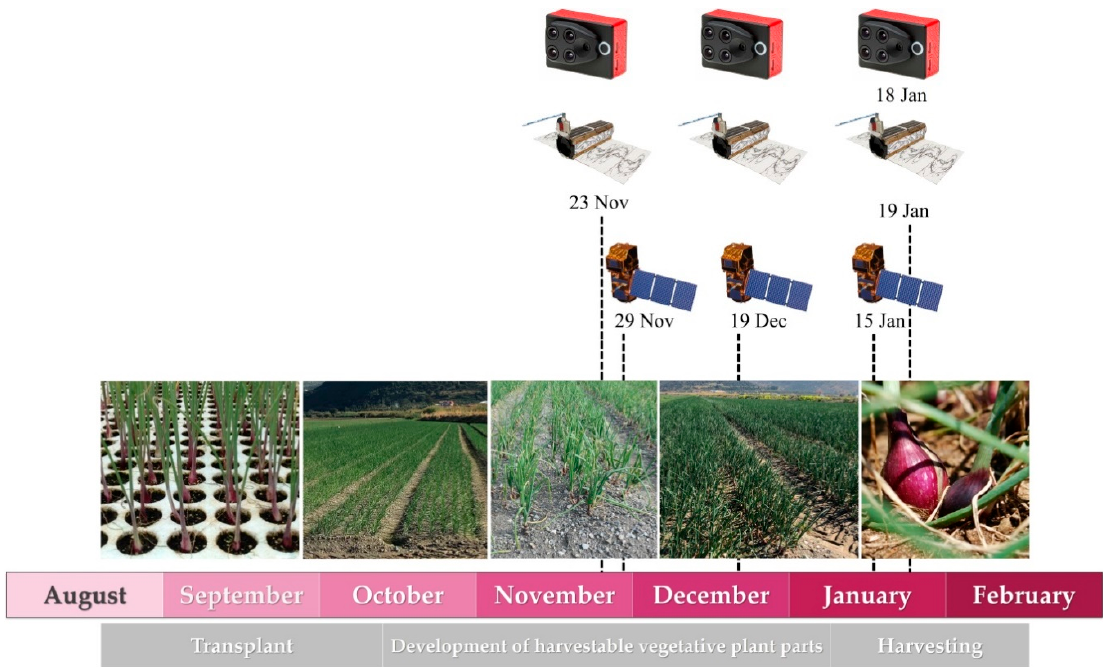
Figure 2. Crop cycle of the onion, dates of the unmanned aerial vehicles (UAVs) surveys, and imagery acquisition.